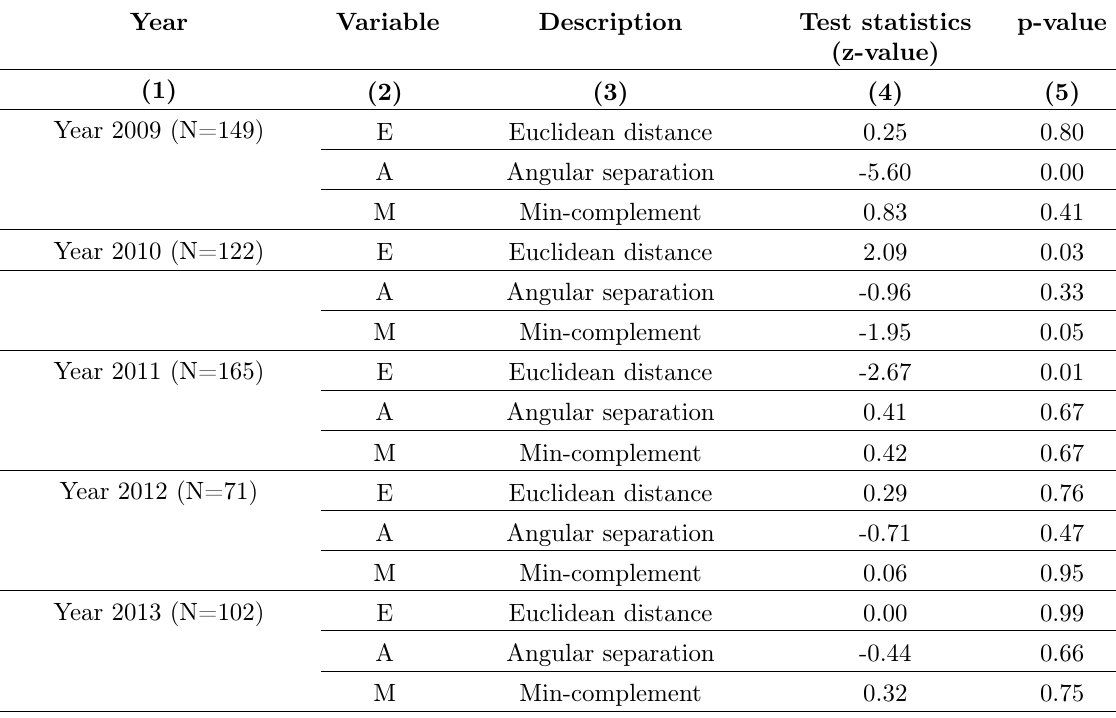
Table 8. Mann-Whitney U-test of technological distance for control and empirical groups (two-